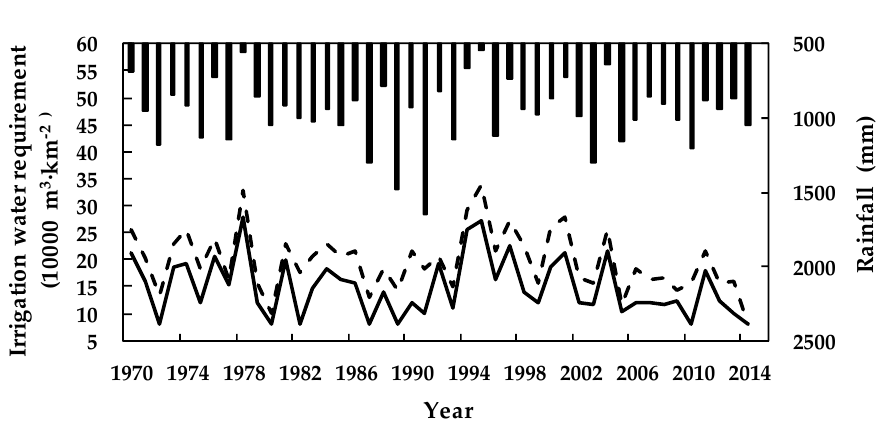
Figure 5. Annual irrigation crop water requirements under conventional and water-saving irrigation methods in the pond irrigation district of Yangdain Town from 1970 – 2014. Table 2. Crop water deficits and deficit ratios under conventional and water-saving irrigation methods in the pond irrigation district of Yangdian Town .